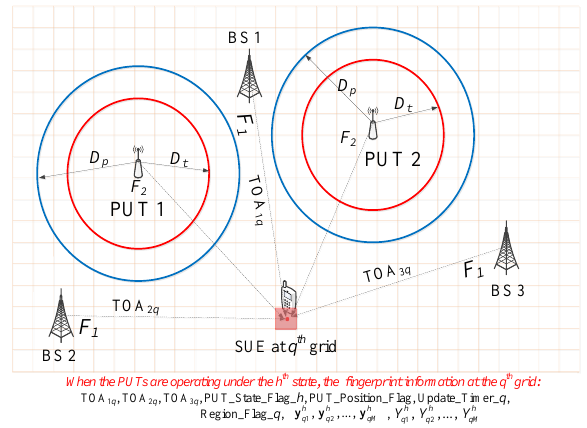
Figure 3. Grid-based sensing scenario and data